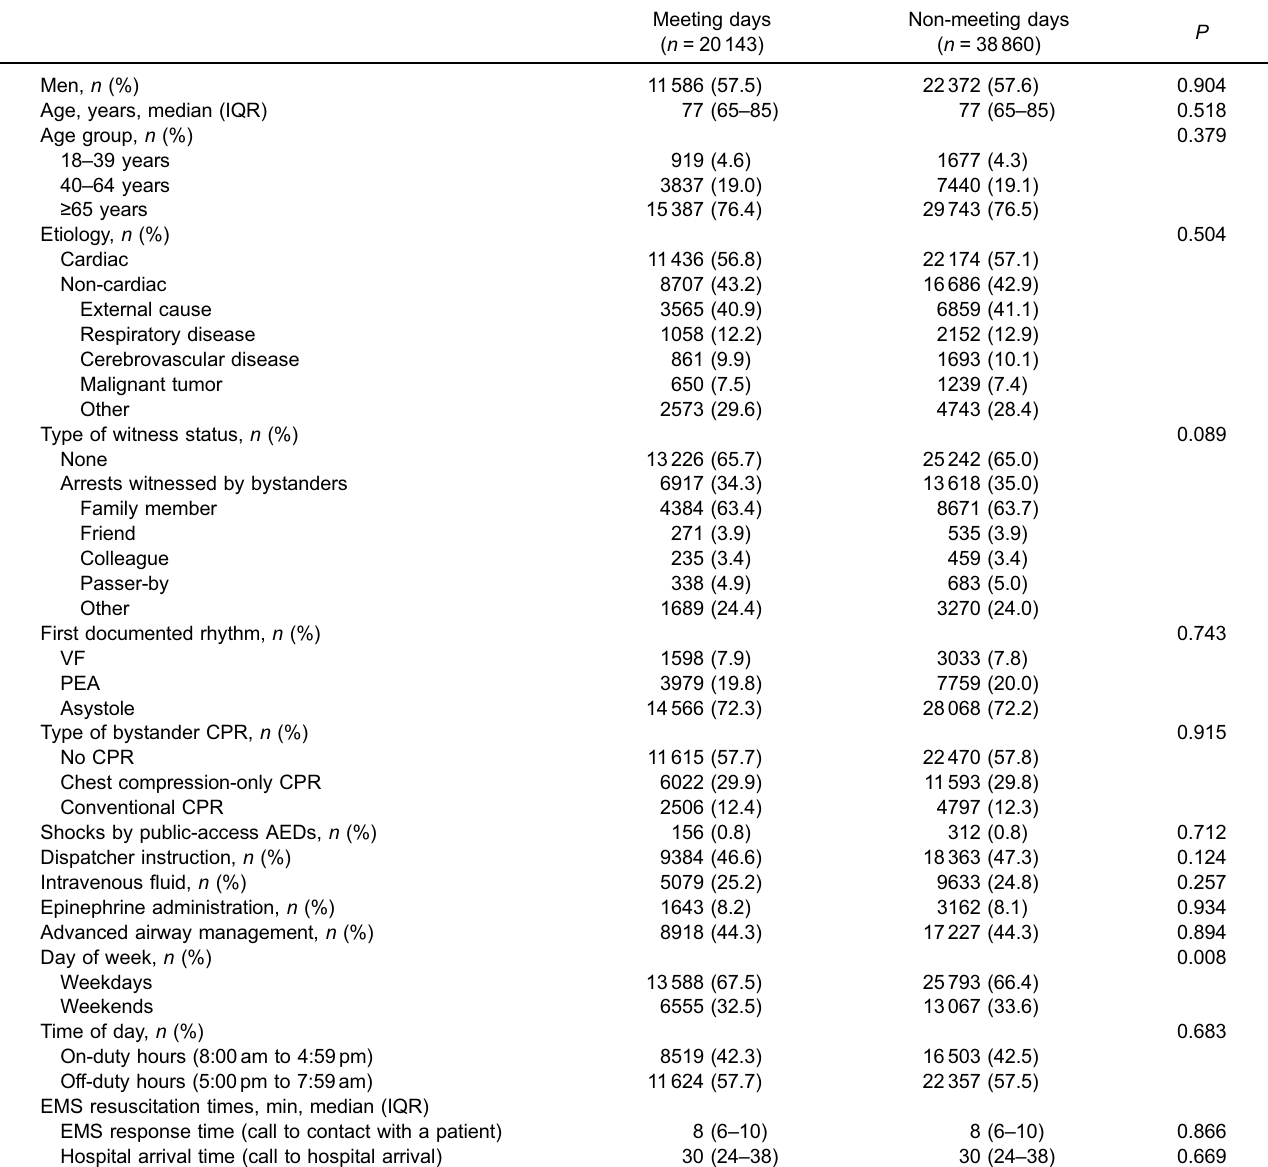
Meeting days ( n = 20143)